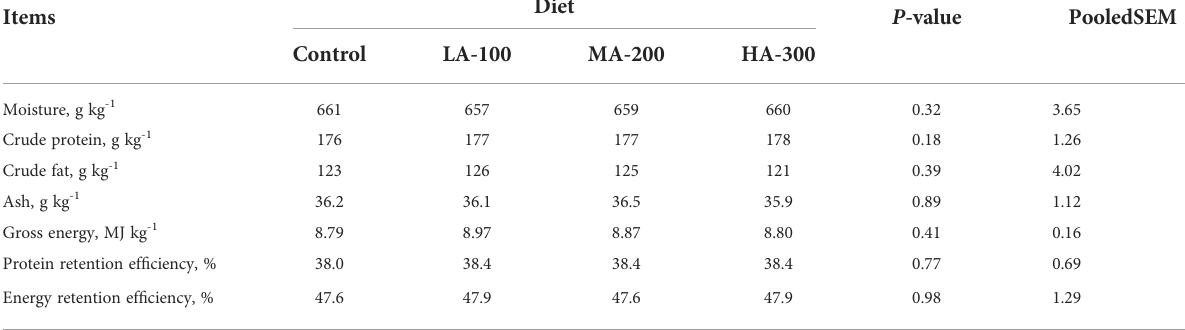
TABLE 2 Whole body composition and nutrient retention ef fi ciency of largemouth bass fed diets with different levels of b -glucan. Items